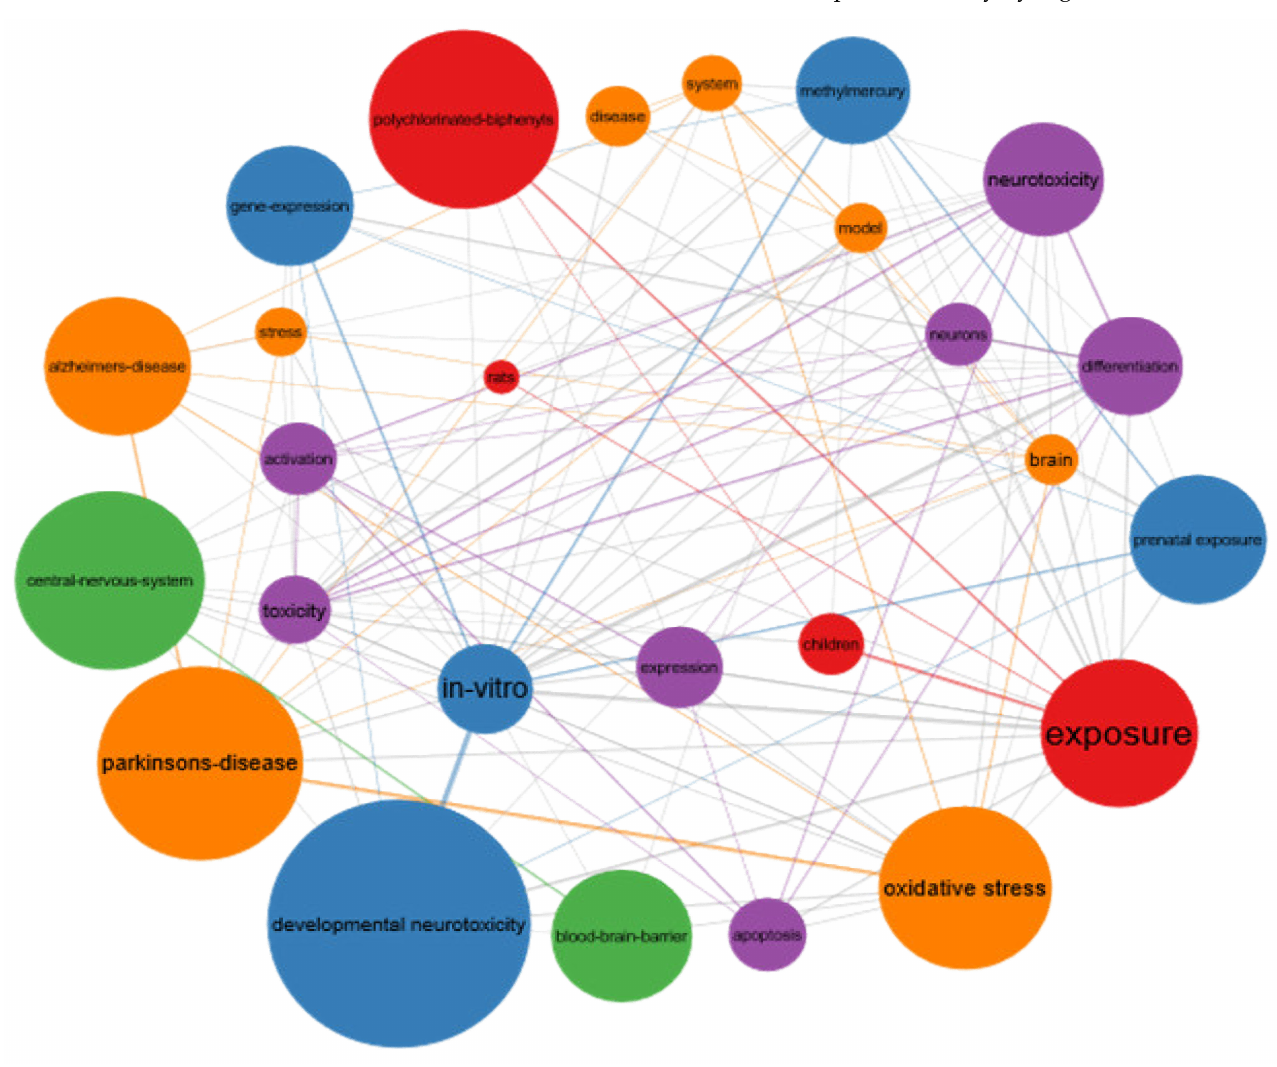
Figure 7. Co-occurrence network (keyword plus) between 2011 and